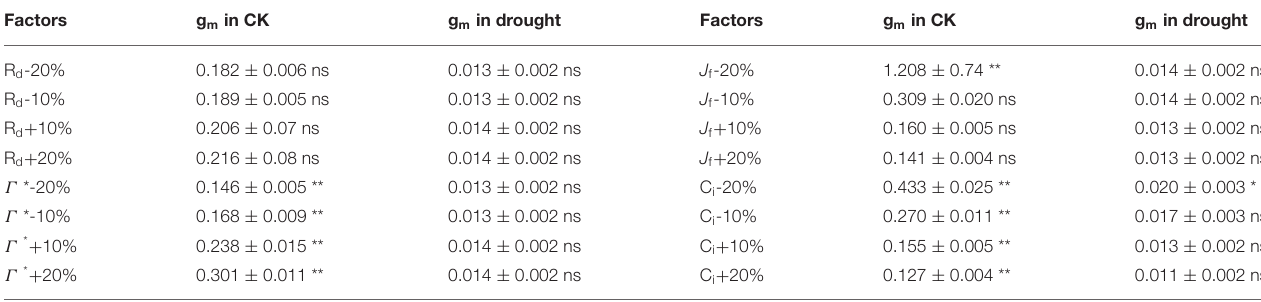
TABLE 2 | Sensitivity analyses of the effects of ± 20% error of light mitochondrial respiration (R d ), chloroplast CO 2 compensation point ( Γ * ), electron transport rate ( J f ), and intercellular CO 2 concentration (C i ) on calculation of g m in well-watered and severe drought tomato at Ψ soil = − 1.44 MPa as compared with the original value of g m